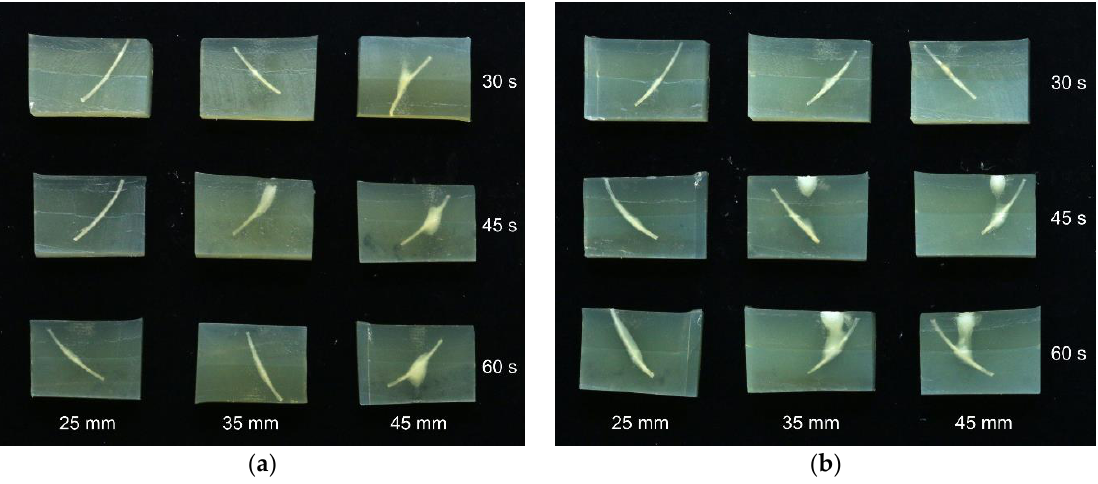
Figure 7. Slices of phantoms with embedded bones, treated at a 25–45 mm distance and for 30–60 s. The phantom temperature was approx. 4 °C before treatment. ( a ) Treated with a 680 kHz transducer; ( b ) Treated with a 1 MHz transducer.